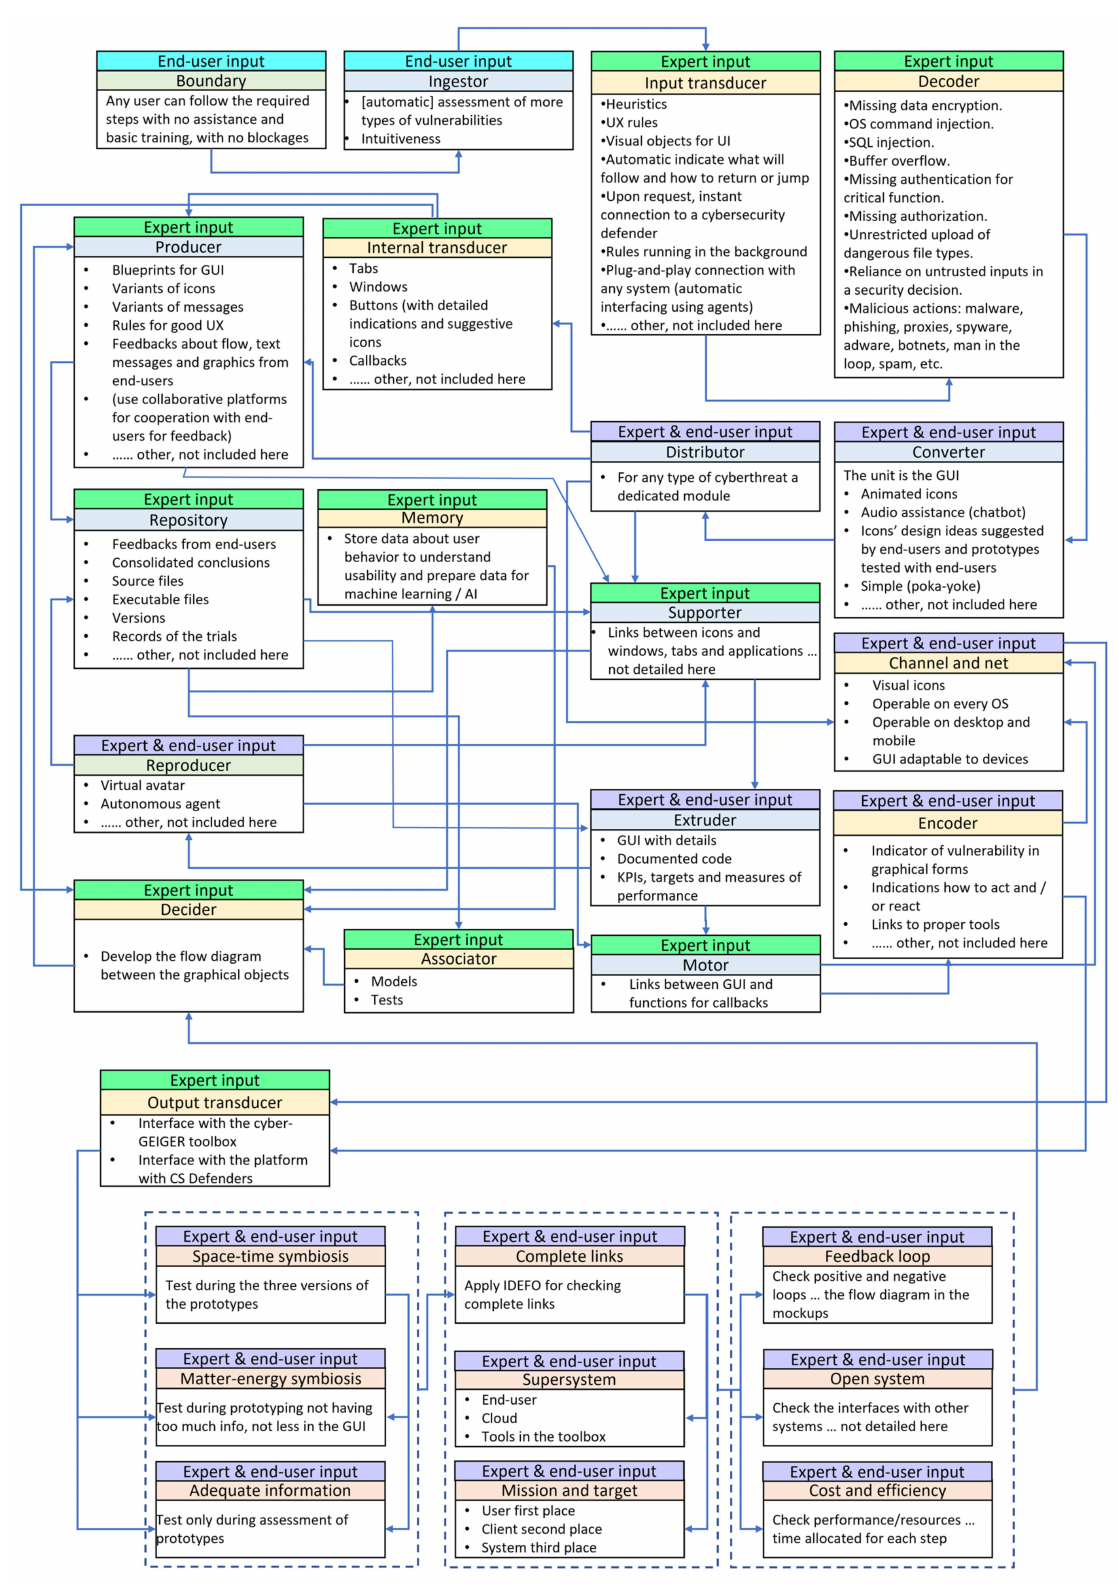
Figure 5. RDFC application on the need to “avoid doing wrong